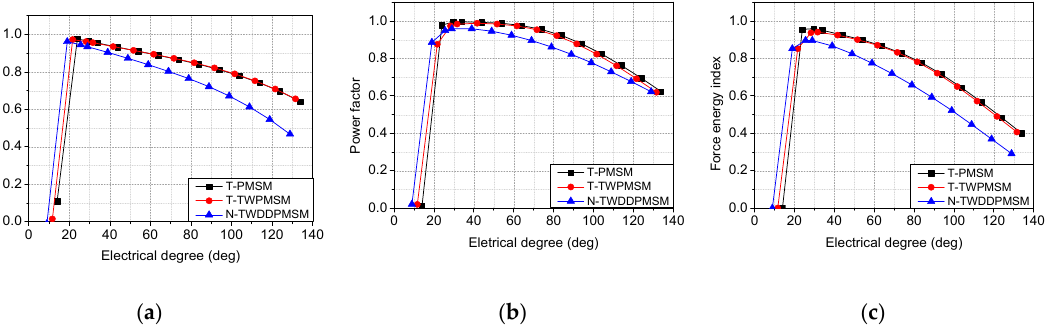
Figure 12. Waveforms of efficiency, power factor, and force energy index: ( a ) efficiency; ( b ) power factor; and ( c ) force energy index.